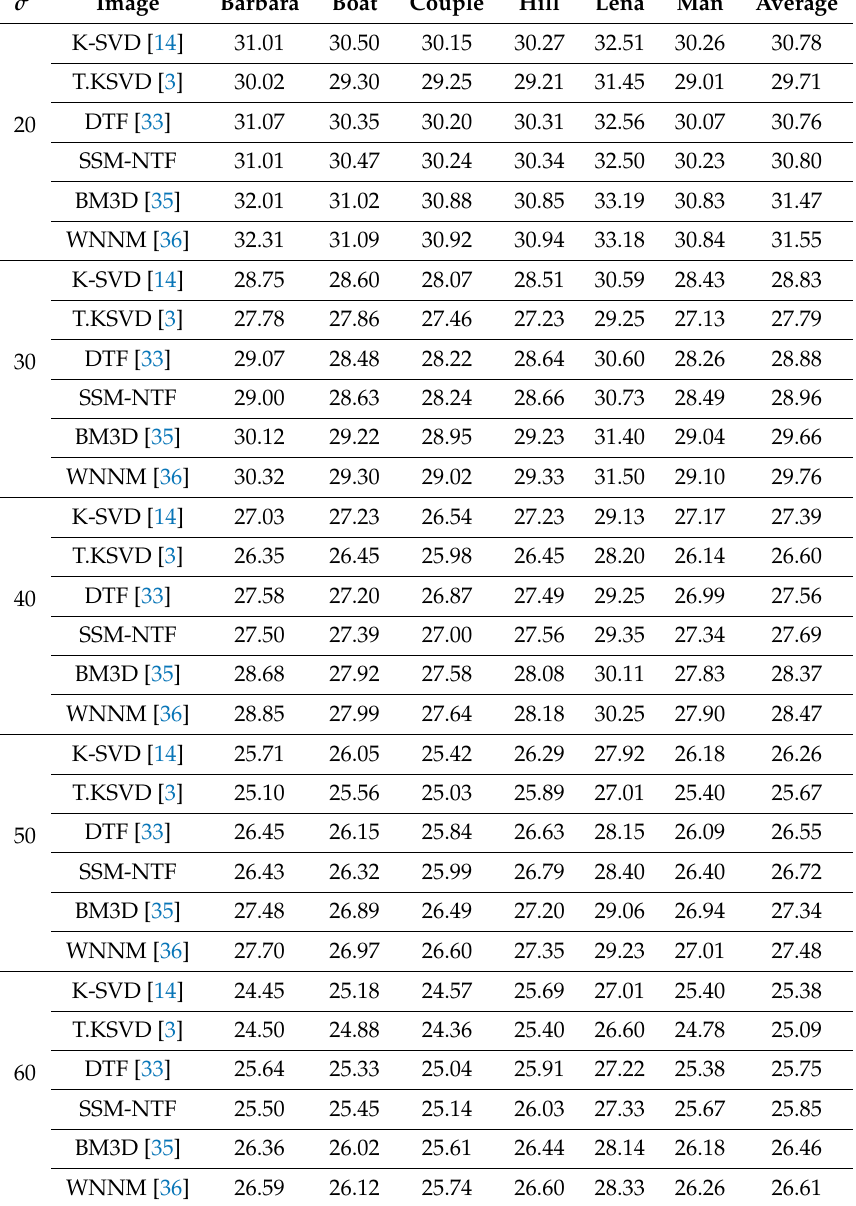
Table 1. Average PSNR results of different noise levels on six